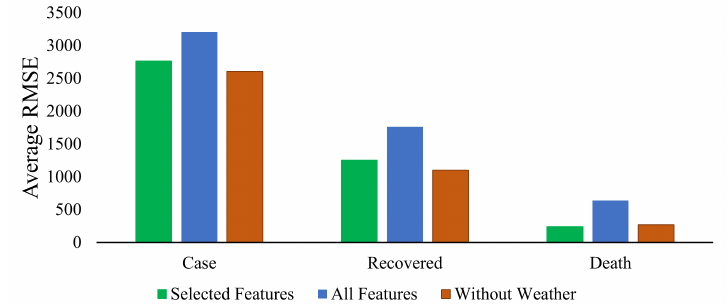
Figure 12. Average RMSE of total cases, recovered, and death using selected features, combined weather data, and without weather data on last 25 days